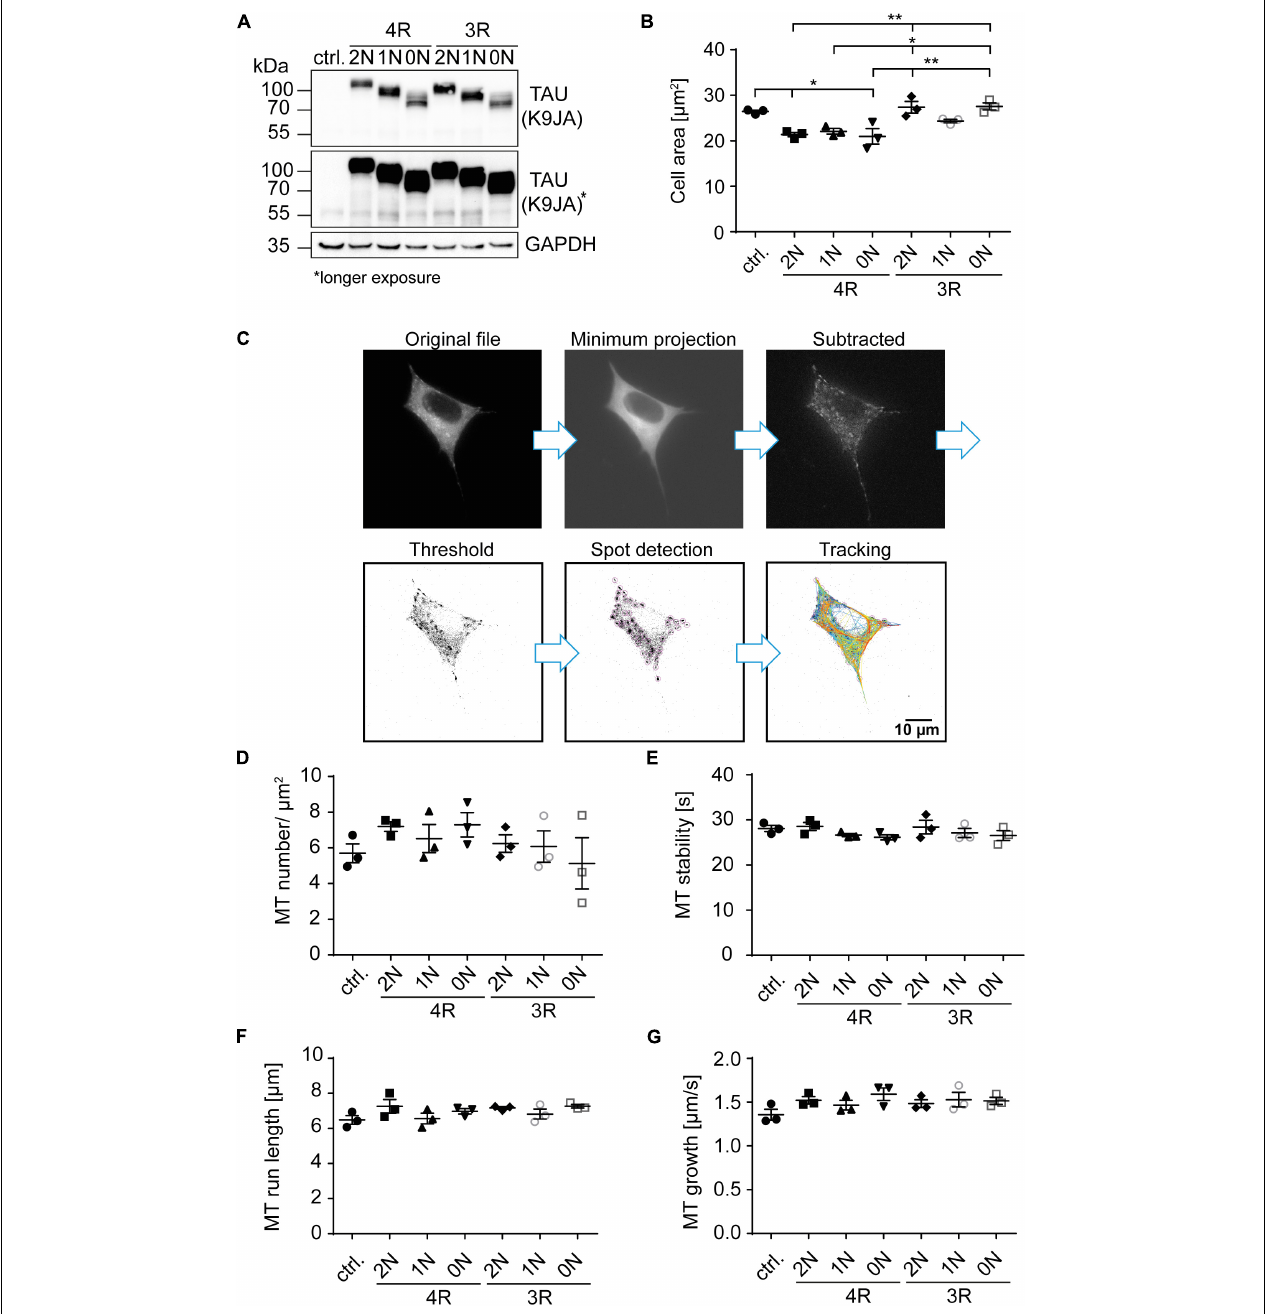
FIGURE 2 | 4R-TAU isoforms decrease cell size and increase microtubule counts in undifferentiated SH-SY5Y neuroblastoma cells. Expression of TAU D 2 isoforms (0N, 1N, 2N, and 3R or 4R) in undifferentiated SH-SY5Y cells. (A) Western blot of SH-SY5Y cells transfected with the corresponding TAU D 2 isoforms. Longer exposure of TAU signal shows negligible endogenous TAU expression ( ∼ 55 kDa). GAPDH was used as a loading control. (B) Cell area was measured from SH-SY5Y cells, co-transfected with tdTomato-N1-EB3 and TAU D 2 . Cell area was analyzed from at least 30 cells. Error bars represent SEM. Statistical analysis was performed by one-way ANOVA with Tukey’s test for correction of multiple comparisons. Asterisks indicate statistical significance: * p ≤ 0.05; ** p ≤ 0.01. (C) Image processing for input into TrackMate. Minimum projection was calculated from all frames and subtracted from all. Afterward, threshold was set, and microtubule dynamics were analyzed by TrackMate. (D–G) Microtubule dynamics of SH-SY5Y cells co-transfected with Dendra2c-tagged TAU isoforms (0N, 1N, 2N, and 3R or 4R) and tdTomato-N1-EB3. Growing microtubule plus-ends were monitored in living cells for 2 min (1 fps). The following parameters were examined: (D) microtubule number (MT number/ µ m 2 ) (normalized to corresponding cell area), (E) microtubule run length ( µ m), (F) microtubule stability (s), and (G) microtubule growth rate ( µ m/s). N = 3, at least five cells were analyzed per condition. Error bars represent SEM. Shapiro–Wilk test was performed to test for normal distribution of data; statistical analysis was performed by one-way ANOVA with Tukey’s test for correction of multiple comparisons for (D–F) . Kruskal–Wallis test with Dunn’s correction for multiple comparisons was performed for panel (G) .